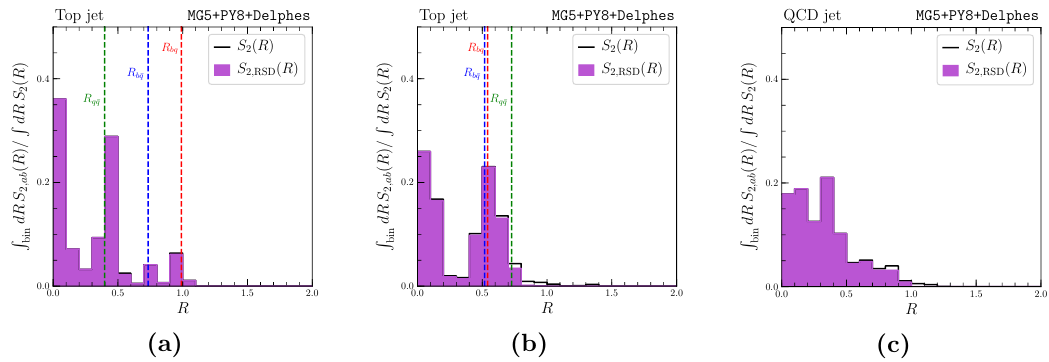
Figure 14. The S 2 and S 2 ; RSD distributions of the top jets and the QCD jet in (cid:12)gure 2. The dashed lines are the characteristic angular scales of the top jets in the parton level.